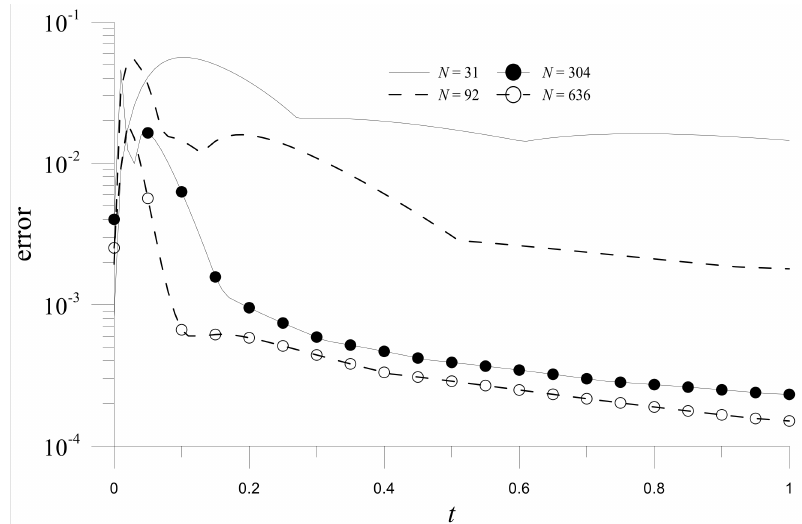
Figure 3. Numerical errors of the Hermite MAPS with different numbers of collocation points for Example 1.